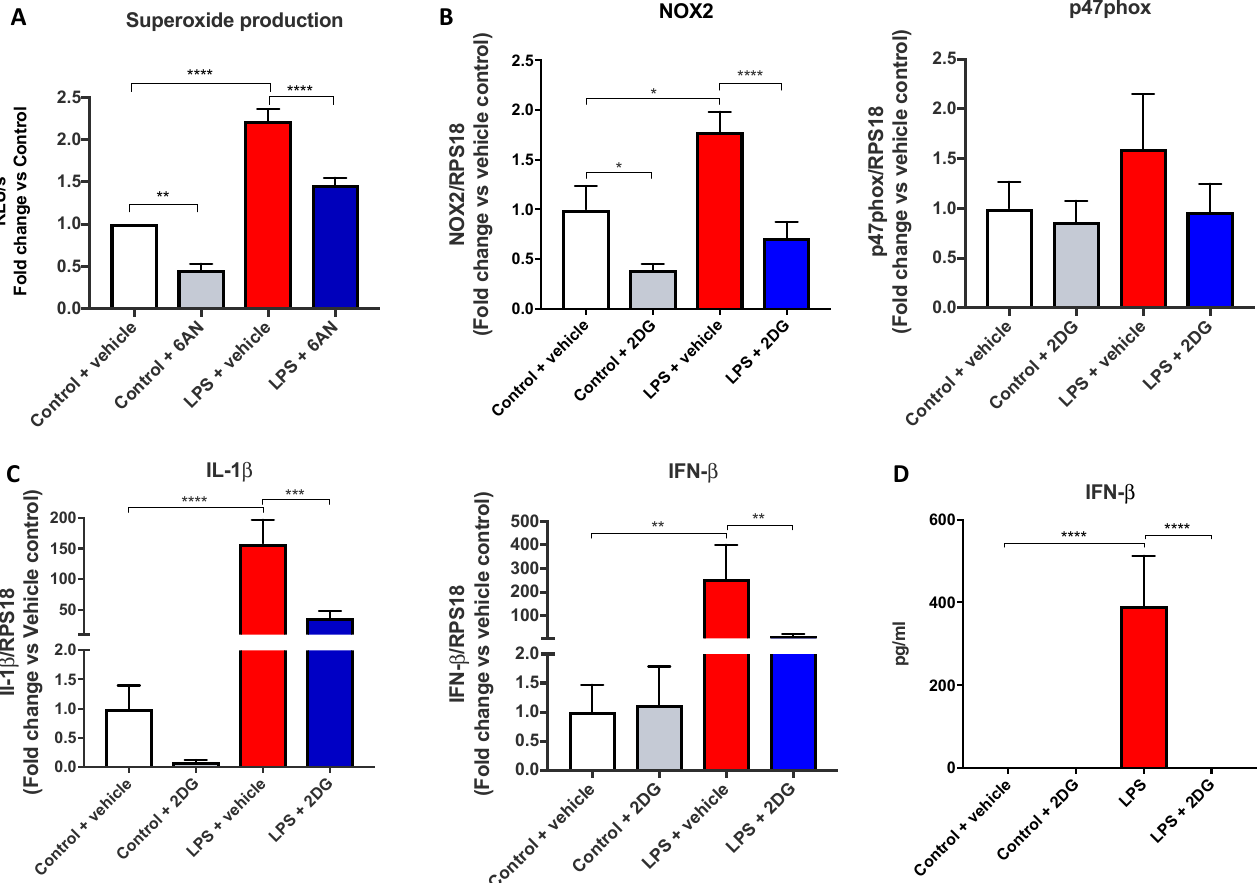
Figure 3. Glycolysis modulates NOX2-dependent ROS generation and IFN- β production . ( A ) Oxidative burst measured by L-012-enhanced chemiluminescence in RAW 264.7 macrophages, ( B , C ) mRNA expression measured using qPCR, or ( D ) IFN- β protein measured by ELISA. Cells were pre-treated with 2-DG (1 mM) for 3 h before being stimulated by LPS (100 ng/mL) for 24 h. Data are presented as mean ± SEM of n = 8–9 experiments. Data are expressed as ( A ) a fold change against the respective control in relative light units (RLU), measured as an average of triplicates over a 60-cycle period, subtracted by blank readings or the fold change against the vehicle control of a peak response over an average of triplicates over the 60-cycle period, subtracted by blank readings, ( B ) and ( C ) fold change vs. control against the housekeeping gene RPS18, or ( D ) in pg/mL. Statistical analysis was conducted via a one-way ANOVA followed by Tukey’s post hoc test for multiple comparisons. * indicates p < 0.05, ** indicates p < 0.01, *** indicates p < 0.001 and **** indicates p < 0.0001.